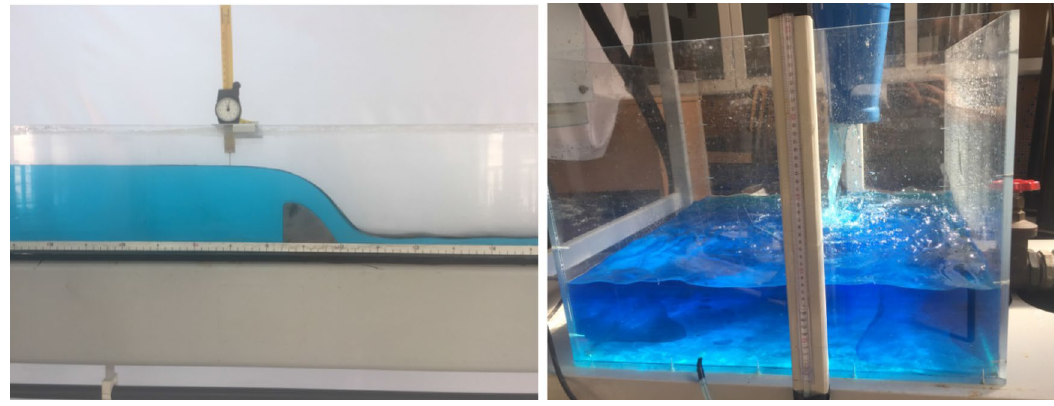
Fig. 5 Side view of water surface profile in test flume and discharge measurement tank